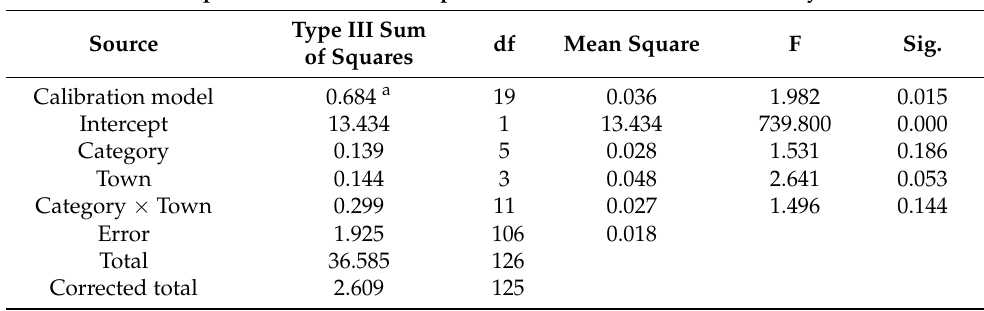
Table 13. Variance analysis of the interaction between categories and towns on the comprehensive urban land accessibility. Dependent Variable: Comprehensive Urban Land Accessibility Type III Sum Source of Squares